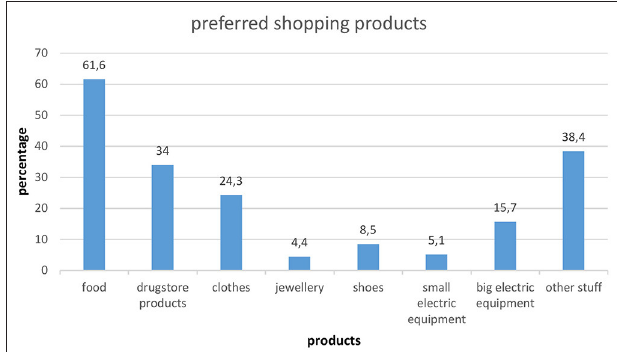
FIGURE 1 | Preferred shopping products of the participants who shopped more after the beginning of the lockdown ( n = 568). Multiple choice option.